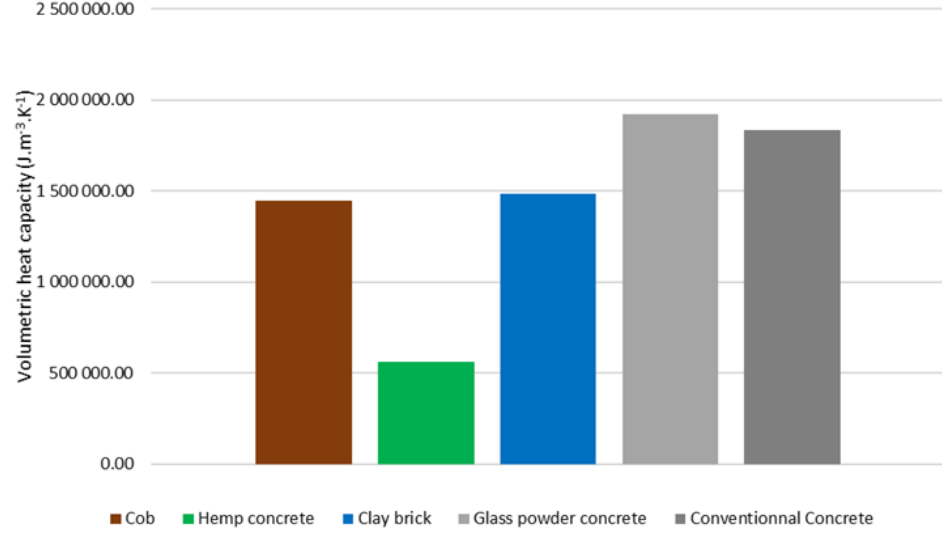
Figure 11. Comparison of cob’s volumetric heat capacity with different materials.